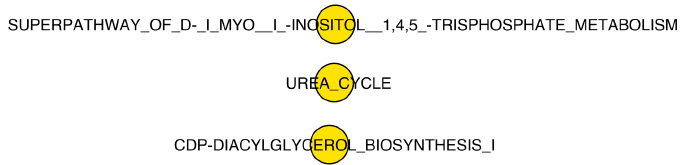
Figure 4. Enrichment map of top-scoring pathway features in tumour classifier example. The small number of nodes reflects the limited number of pathways provided to the toy example model, and also reduced parameter values for model building. See Figure 5 for an example of a more informative enrichment map produced by running a real-world